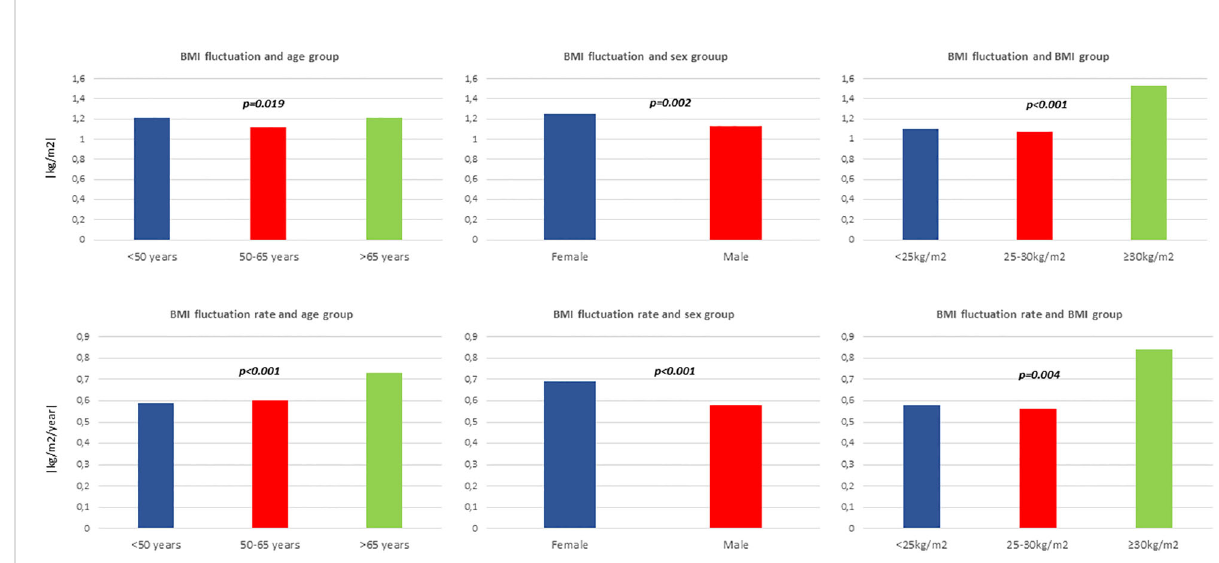
FIGURE 3 Mean body mass index (BMI) fl uctuation (|kg/m2|) and mean BMI fl uctuation rate (|kg/m2/year|) according to age groups, sex and baseline